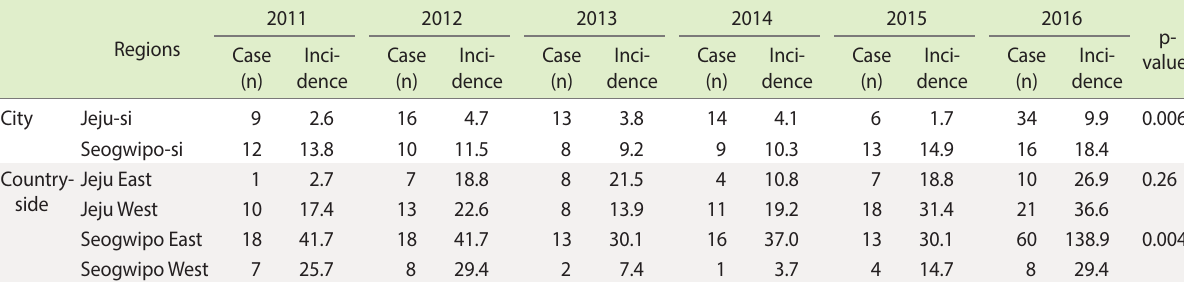
Table 2. Regional incidence 1 of scrub typhus in Jeju Island Regions